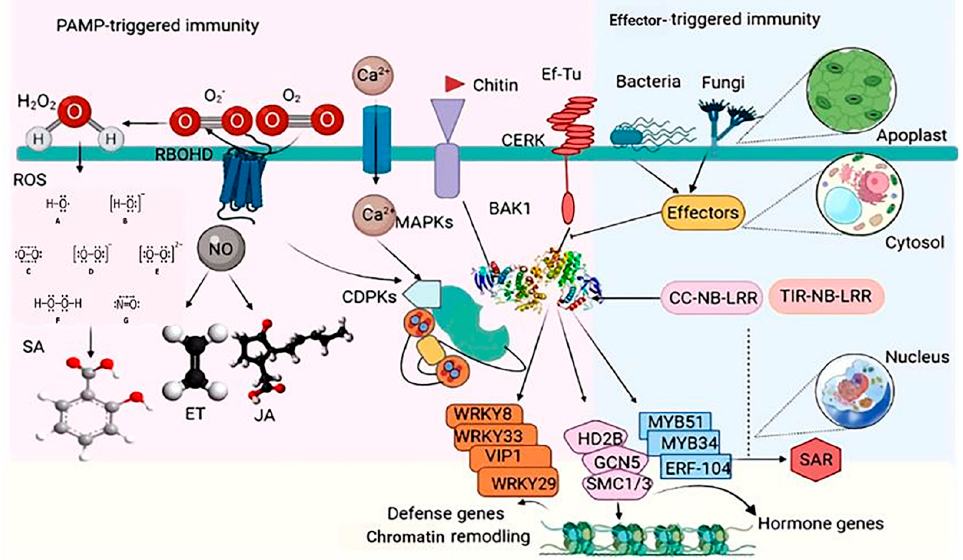
Figure 2. Schematic view of plant intrinsic immunity PAMP-triggered immunity and ETI in plants. The recognition of microbe-dependent molecular patterns (MAMPs) such as flagellin, elongation factor-Tu (EF-Tu), and chitin by cognate sample assessment receptors (PRRs; FLS2, EFR, and CERK) activates many signaling pathways, resulting in the production of reactive oxygen species (ROS), nitric oxide (NO), Ca 2+ flux, and the activation of several protein kinases such as CDPKs and MAP kinases (MAPKs). Pathogens release effector molecules into the plant to repress these primary signaling events. However, some plant varieties may know effectors with the aid of R proteins (CC-NB-LRR and TIR-NB-LRR) to compel a hypersensitive response (HR) and systemic